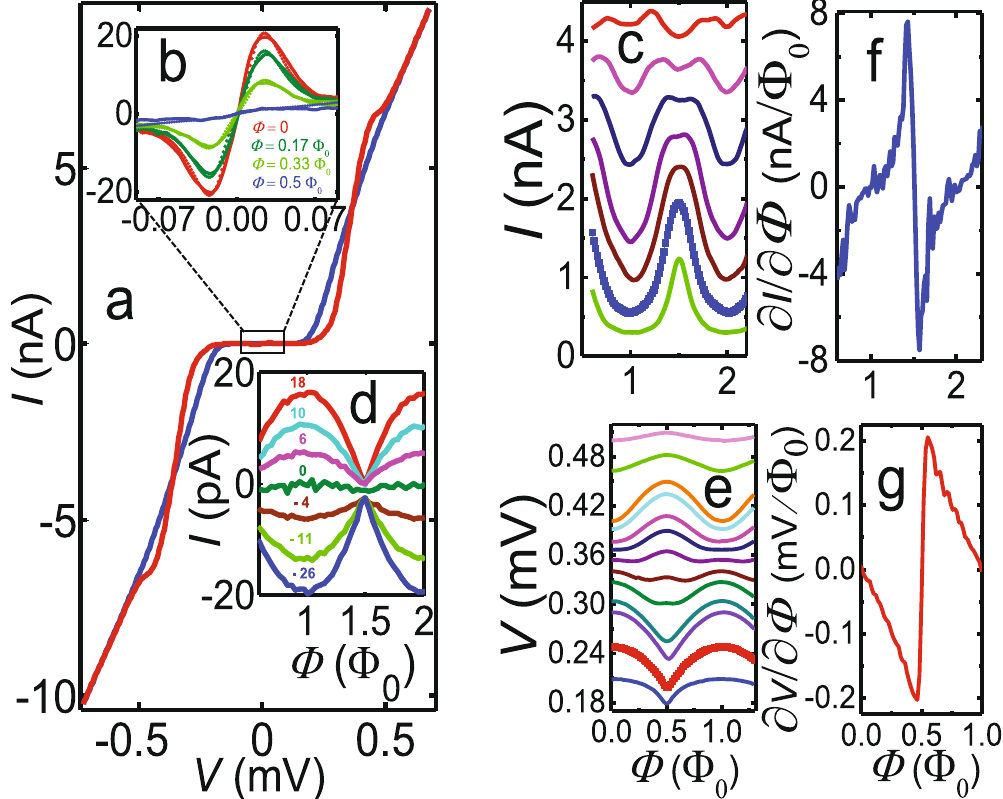
Figure 2. DC transport measurements. (a) IV characteristics at T = 60 mK, measured at two values of magnetic flux Φ = 0 (red solid line) and Φ = 0.5 Φ 0 (blue solid line), respectively. (b) Flux modulation of the IV curve (solid lines) around zero bias voltage at four values of magnetic flux between Φ = 0 and Φ = 0.5 Φ 0 , together with the theoretical model at each flux (dotted lines). (c) Current modulation I ( Φ ) at various fixed bias voltages  ∆ V e / , and (d) , in the sub-gap region close to zero bias voltage. Here the bias voltages are indicated in microvolts. (e) Measured flux-to-voltage curves V ( Φ ) at several values of the bias current through the device. (f) Current responsivity ∂ I / ∂Φ and (g) , voltage responsivity ∂ V / ∂Φ as functions of the magnetic flux at the optimum bias points, V = 0.249 mV and I = 4.2 nA,